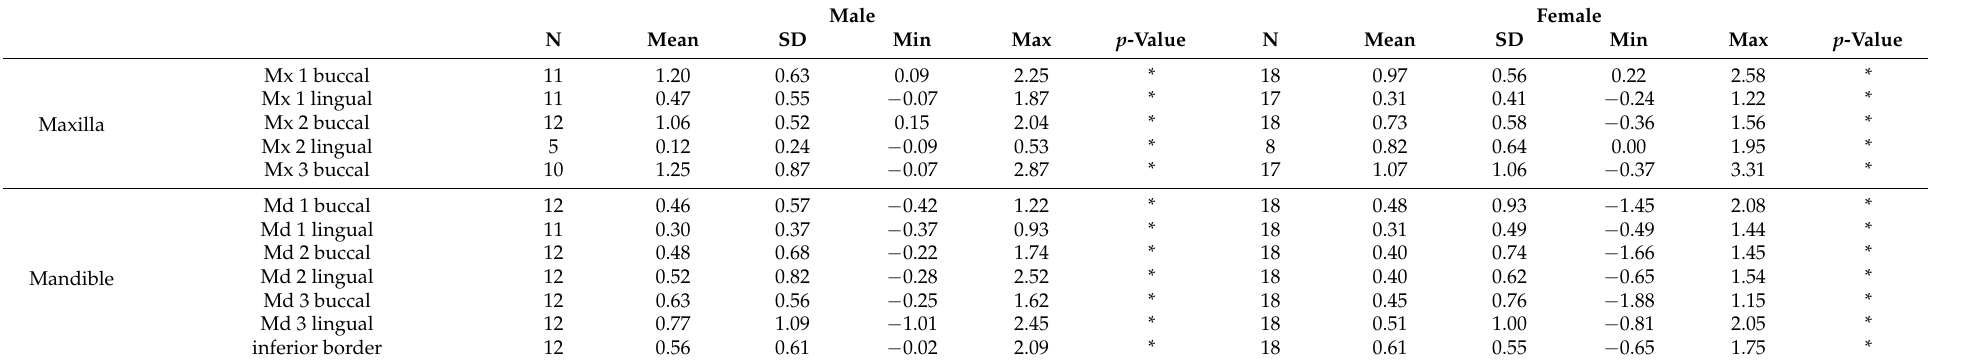
Table 2. Dentoalveolar Transverse Changes Per Year in Males and Females (*, p < 0.05).